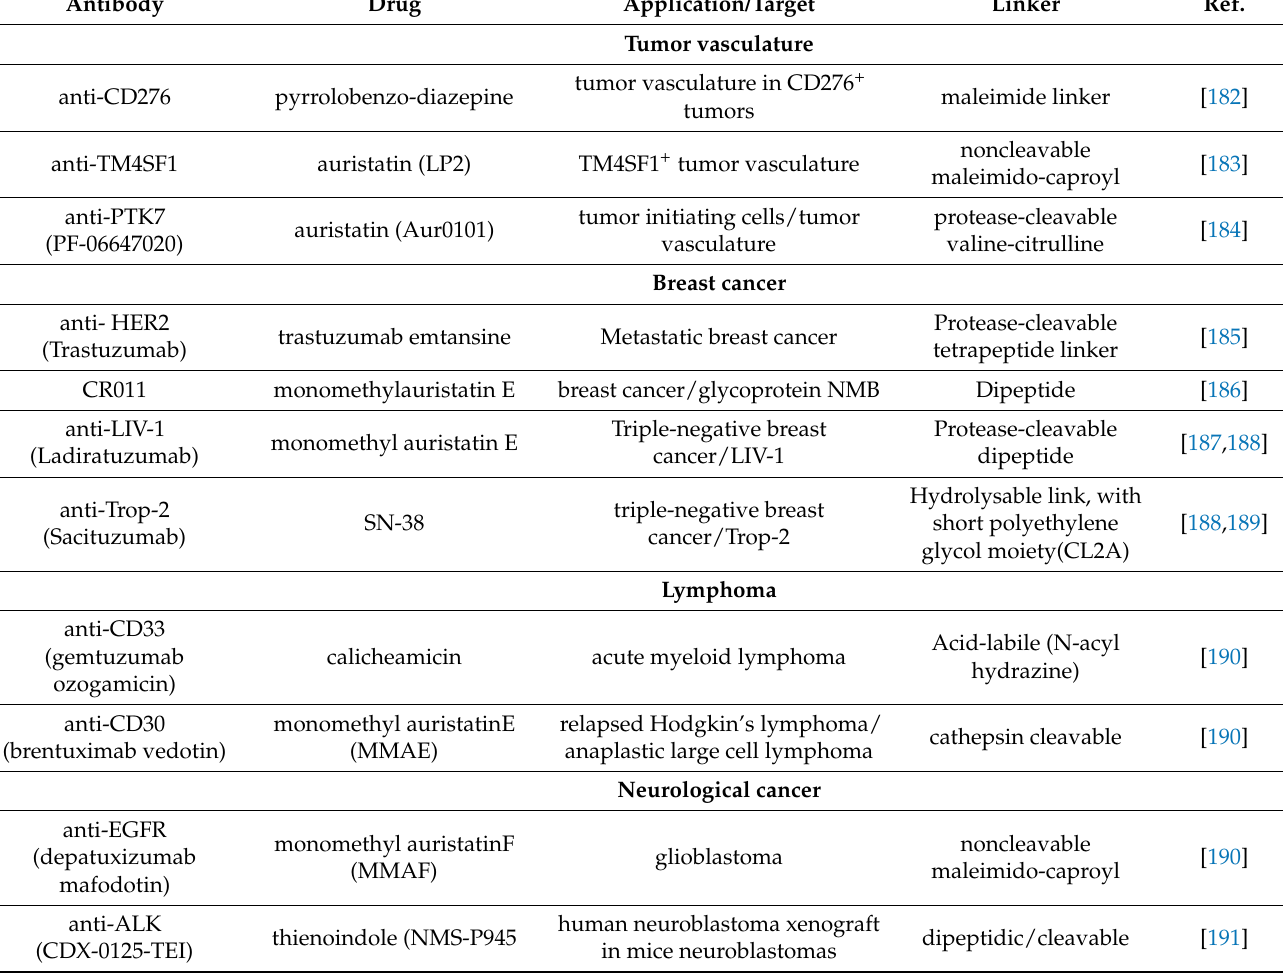
Table 3. Antibodies used for specific drug delivery to various types of